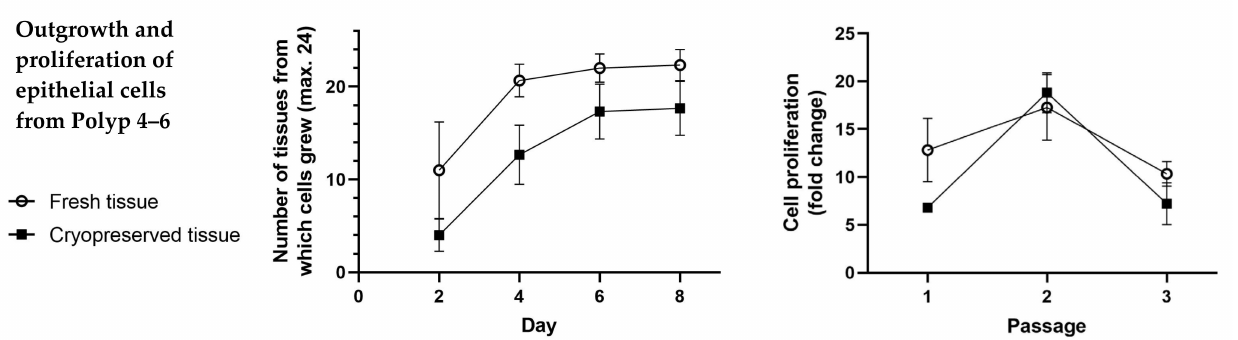
Figure 4. Statistic evaluation of overall outgrowth and proliferation of Polyps 4–6. The outgrowth rate of epithelial cells from fresh tissue was, on average, higher than that of epithelial cells from cryopreserved tissue at any time point ( left ). However, the differences were not significant ( p > 0.05 on day 2, day 4, day 6, and day 8). Proliferation rates were not significantly different up to the